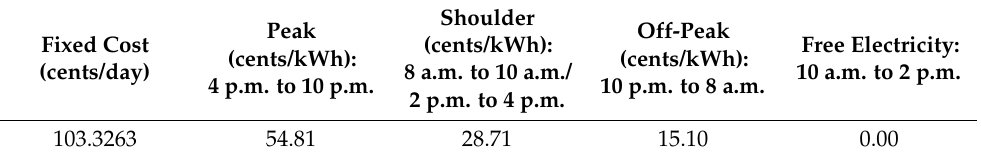
Table 3. The TOU (time of use) tariff of the VPP for the residents.